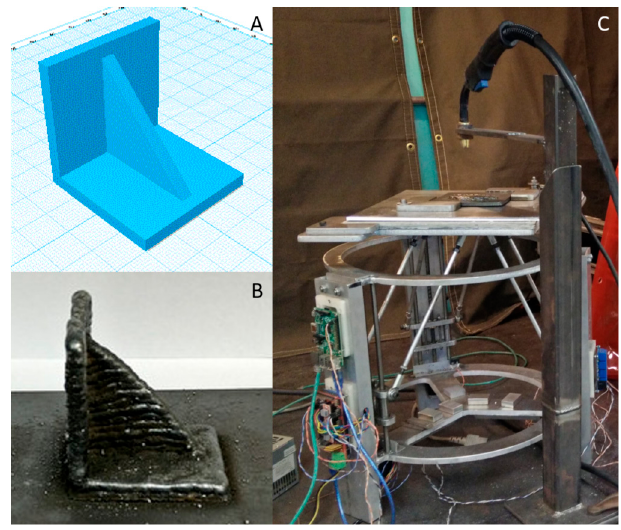
Figure 1. A bracket and metal 3-D printer ( A ) 3-D model; ( B ) metal 3-D printed part on